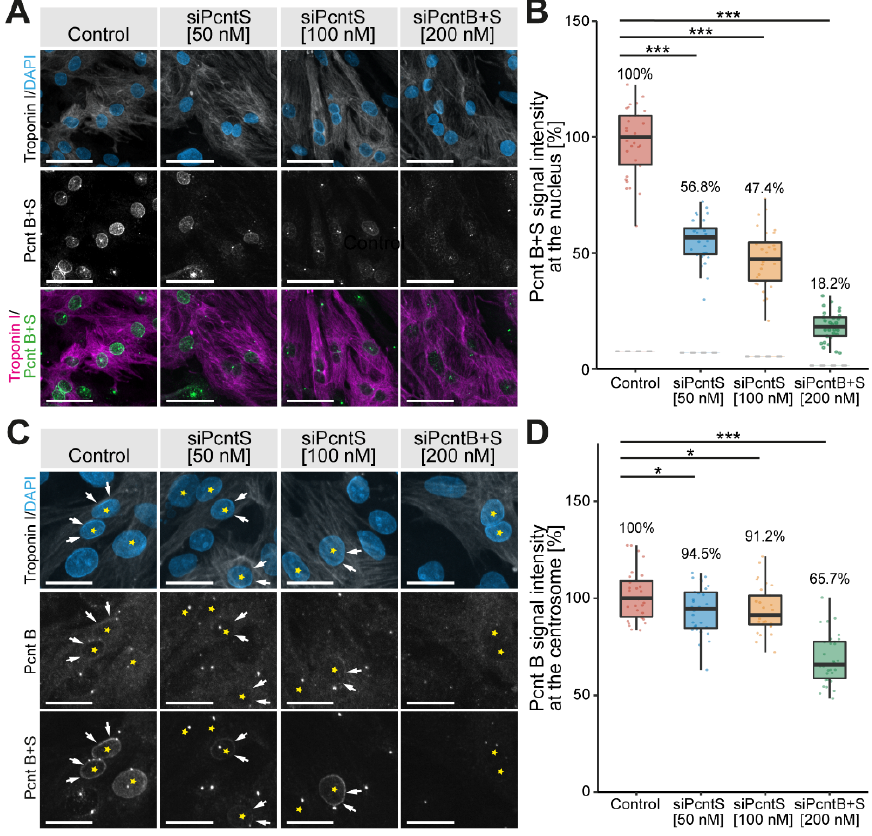
Figure 1. Immunofluorescence analysis of Pcnt S and Pcnt B localization. P3 cardiomyocytes were mock-transfected (Control) or transfected with SiRNAs to deplete Pcnt S or Pcnt S + B as indicated. ( A ) Immunofluorescence analysis of Pcnt expression in cardiomyocytes (troponin I) utilizing an antibody binding to both Pcnt S and Pcnt B (Pcnt B + S). Nuclei were visualized with DAPI (DNA). ( B ) Semi-quantitative analysis of median intensity of nuclear Pcnt B + S signal in ( A ). ( C ) Immunofluorescence analysis of Pcnt expression in cardiomyocytes (troponin I) utilizing an antibody binding to both Pcnt S and Pcnt B (Pcnt B + S) and an antibody detecting specifically Pcnt B. Nuclei were visualized with DAPI (DNA). ( D ) Semi-quantitative analysis of maximum intensity of the Pcnt B signal per cardiomyocyte in ( C ) as an approximation of the centrosomal Pcnt B signal. Yellow asterisk: cardiomyocyte nucleus. White arrows: nuclear envelope of cardiomyocytes. For the experiments, ≥ 2000 cardiomyocytes were analyzed per experimental condition. Scale bars: 50 µ m. Data are mean ± SD, n = 3, *: p < 0.05, ***: p <